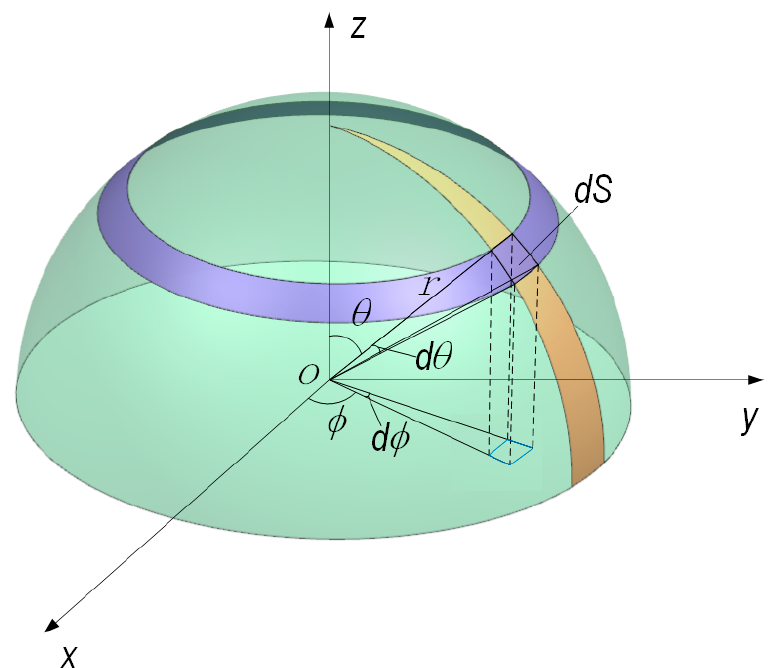
Figure 2. Schematic diagram of light flux calculation.